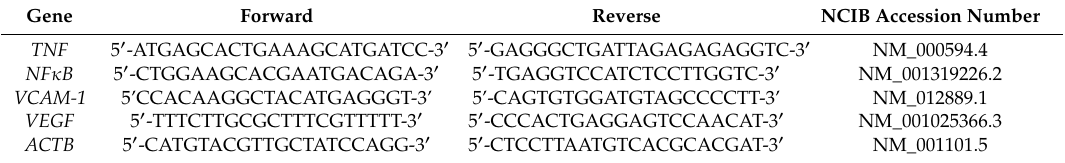
Table 1. Primer pairs employed in PCR studies conducted in this study a